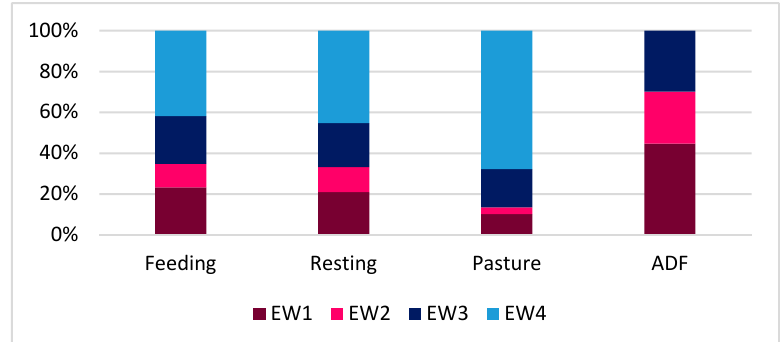
Figure 4. Percentage distribution of the four eye white classes in each context (feeding, resting, pasture, ADF–avoidance distance test at the feeding rack).